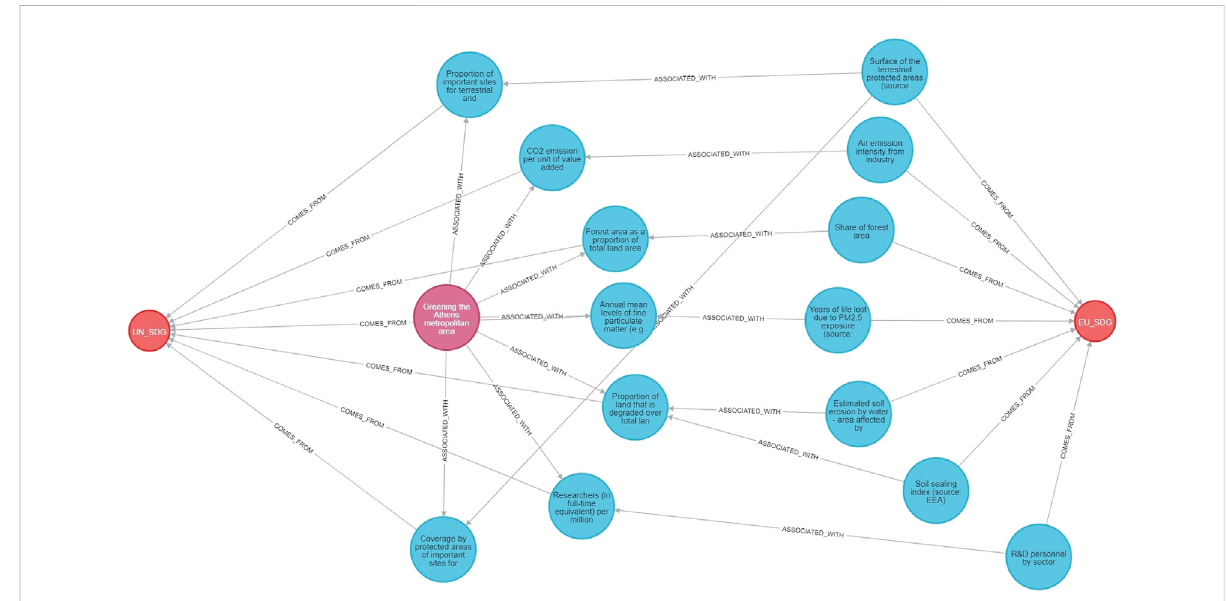
FIGURE 14 Interlinking of the UN and the EU SDG indicators for a speci fi c Goal in a case study in